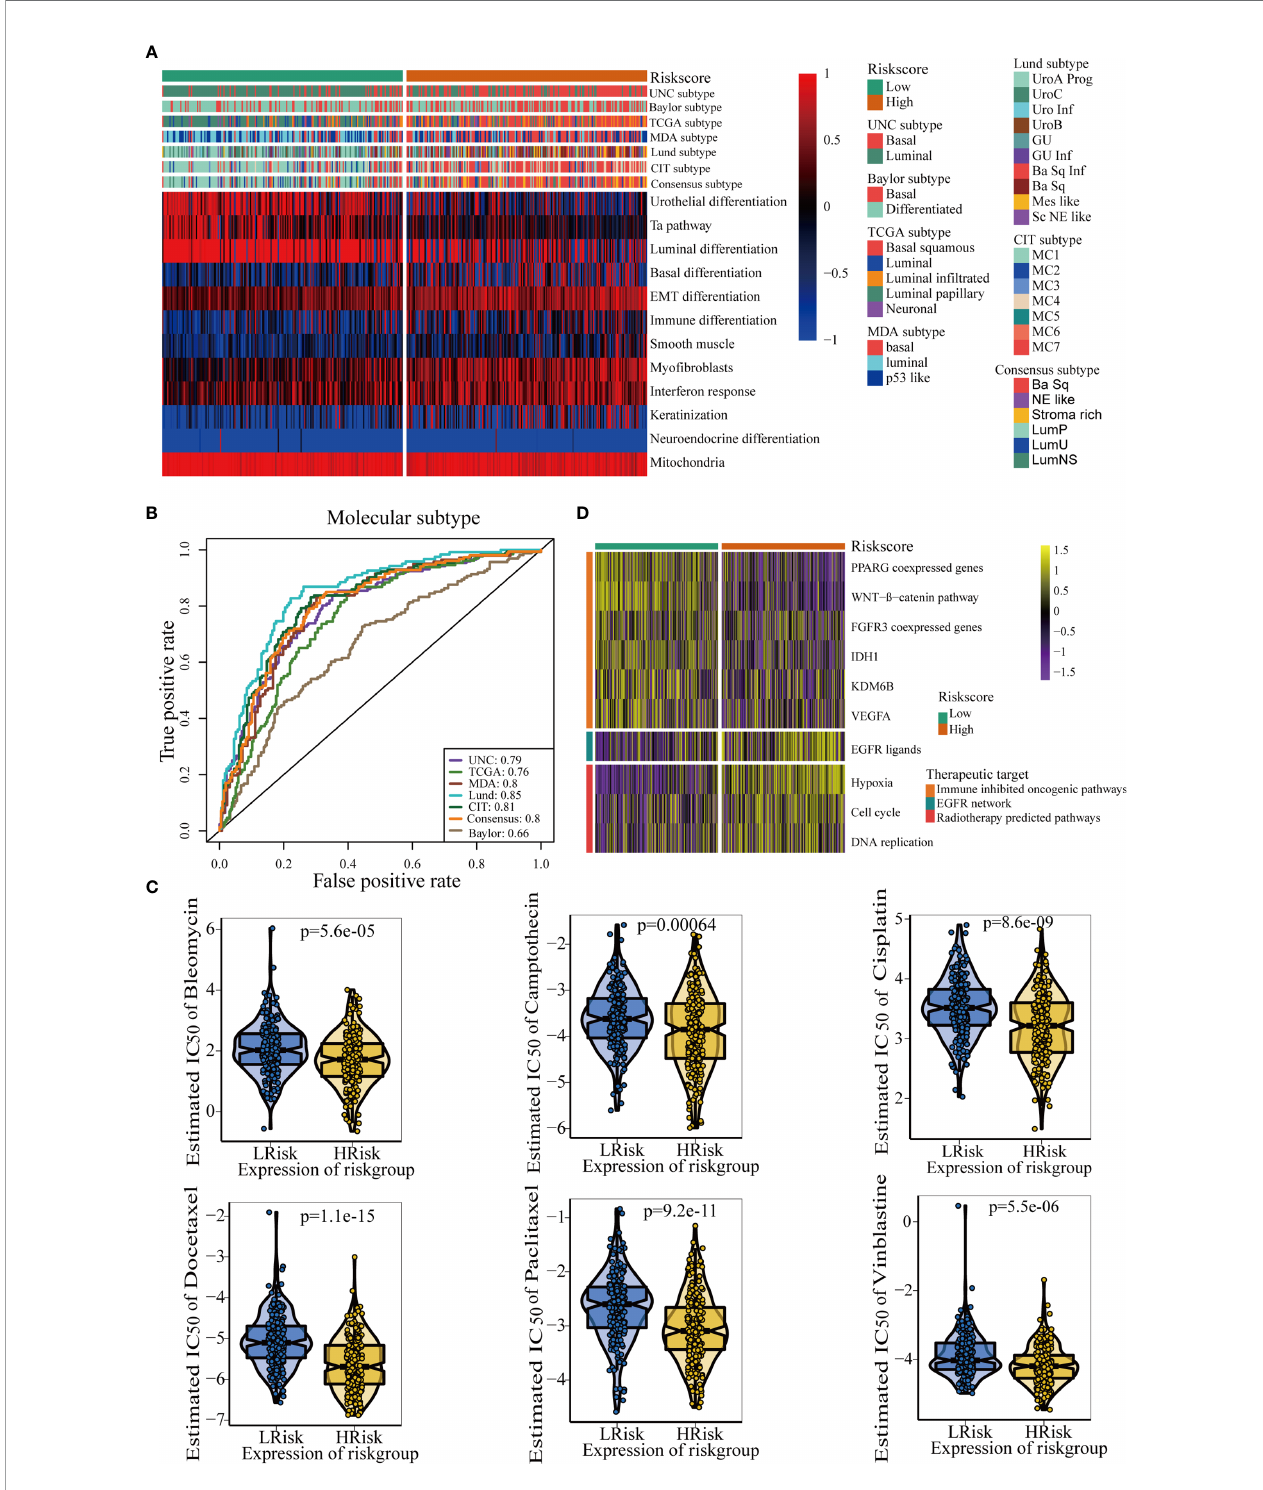
FIGURE 5 | The TGF- b risk score predicted molecular subtypes and promoted individual precision medicine for BLCA. (A) Correlations between TGF- b risk score, bladder cancer signatures, and molecular subtypes from seven algorithms. (B) Predictive accuracy of the TGF- b risk score for molecular subtypes in several different methods. (C) There are differences in the therapeutic responses to six chemotherapy drugs. (D) Relationships between TGF- b risk score and the enrichment scores of several therapeutic